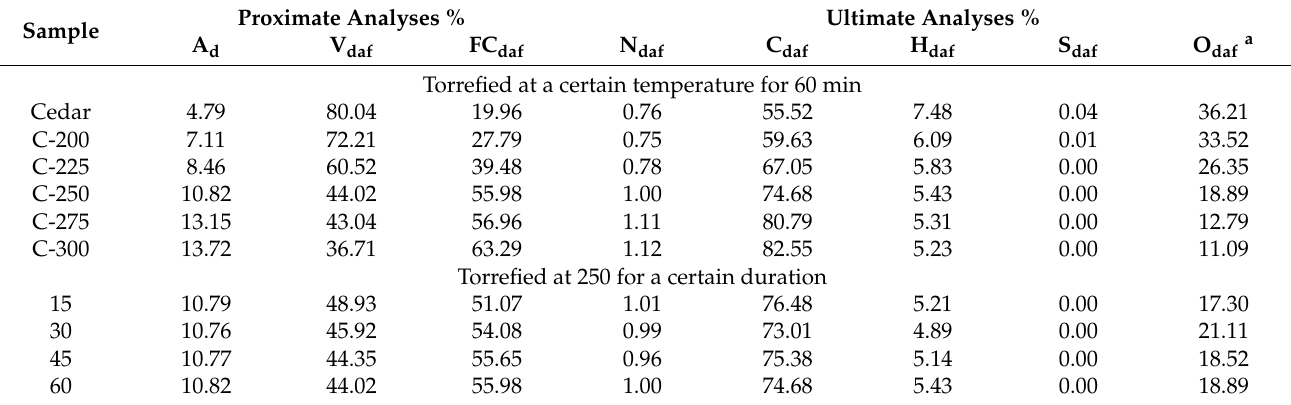
Table 2. The proximate and ultimate analyses of raw and torrefied cedar.